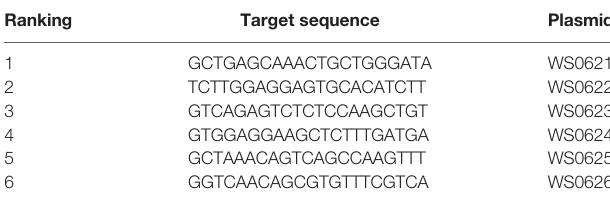
TABLE 2 | CMPK2 target